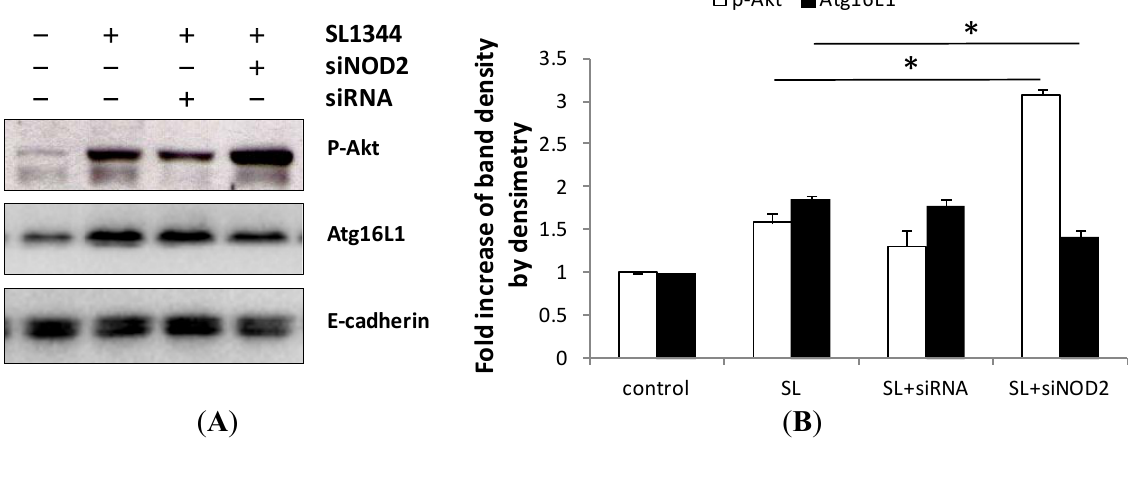
Figure 5. Effect of NOD2 knockdown on recruitment of Atg16L1 and activation of Akt in Salmonella -infected Caco-2 cells. Caco-2 cells were transfected with control siRNA (siRNA), and NOD2 siRNA (siNOD2) for 48 h and then uninfected or infected with wild-type S . typhimurium strain SL1344, as described in the Experimental Section. Proteins were harvested and Western blot analysis of phosphorylated Akt and Atg16L1 were done. E-cadherin was done for normalization of membrane proteins. Representative immunoblots ( A ) and densitometric quantification of immunoreactive bands of phosphorylated Akt (p-Akt) and Atg16L1 ( B ) are shown. The relative band intensities of p-Akt (white) and Atg16L1 (black) were quantified as fold increases compared with the control cells. Each value represents the mean ± SEM of 3 independent experiments. An asterisk indicates a significant difference ( p <